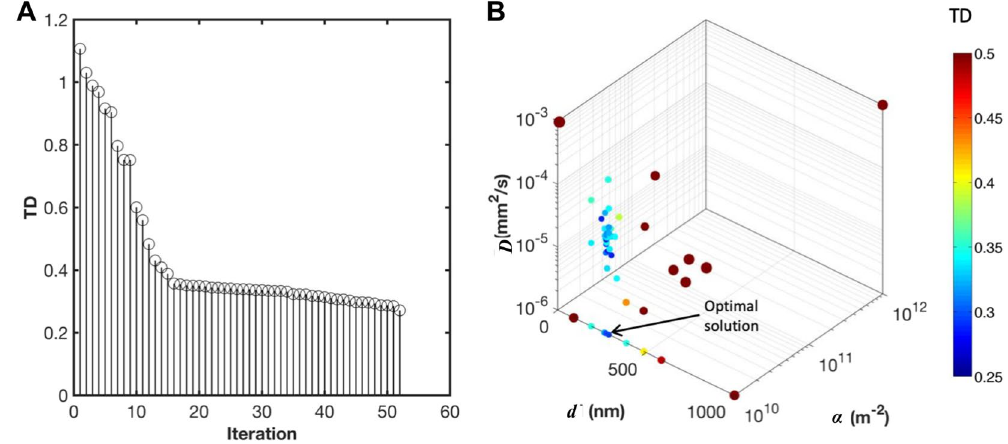
Figure 2. Optimization of nanoparticle size, avidity, and drug diffusivity. ( A ) Progress of MADS in obtaining the optimal solution. ( B ) Trial points selected by MADS, where the color and size of the points correspond to the value of TD. The smallest point refers to the optimal solution of TD minimization problem (shown by the